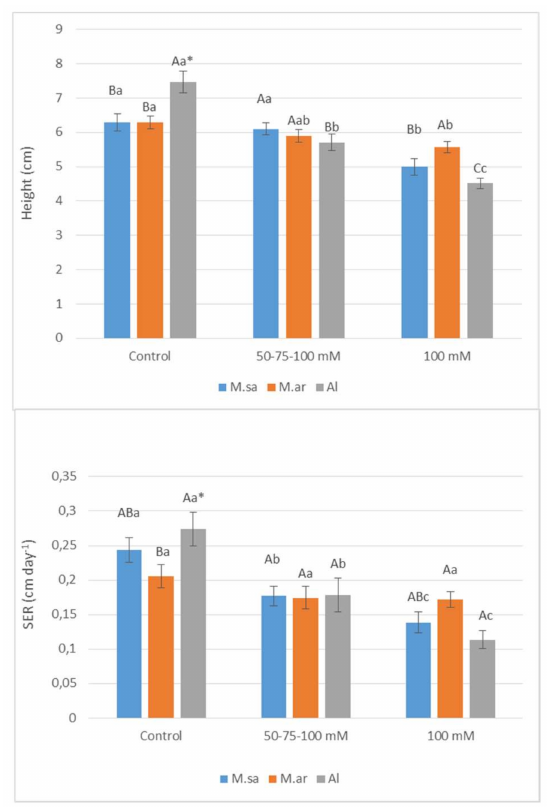
Figure 1. The stem height and the stem elongation rate (SER) of M. arborea (M. ar), M. sativa (M. sa), and Alborea (Al) under control, 50-75-100 mM and 100 mM. The vertical bars indicate the mean ± stan- dard error (SE). * The different small letters indicate significant differences for the same entry among treatments; different capital letters indicate significant differences for the same treatment among the entries at p < 0.05 (Tukey’s test).